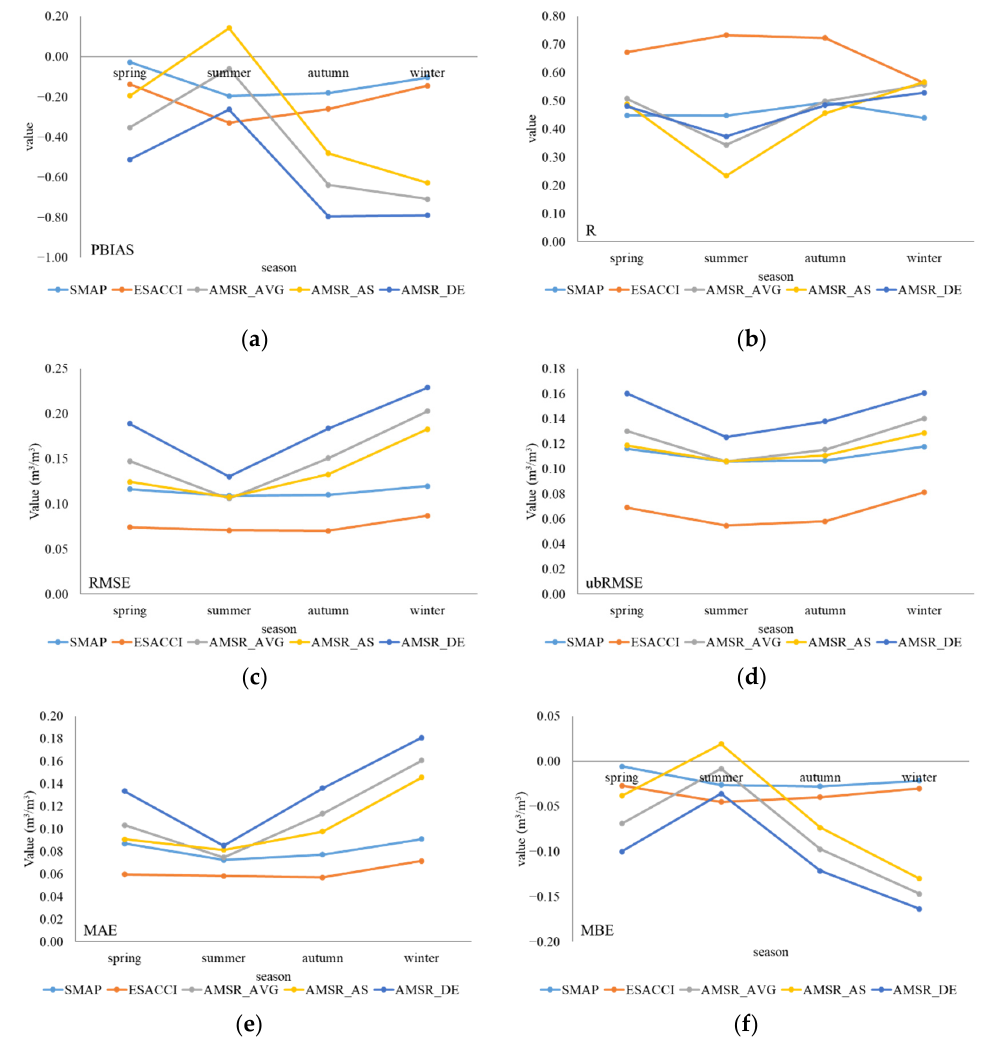
Figure 5. Performance of six indicators of five products at different seasons. ( a ) PBIAS; ( b ) R ( p -value < 0.0001); ( c ) RMSE; ( d ) ubRMSE; ( e ) MAE; and ( f ) MBE .